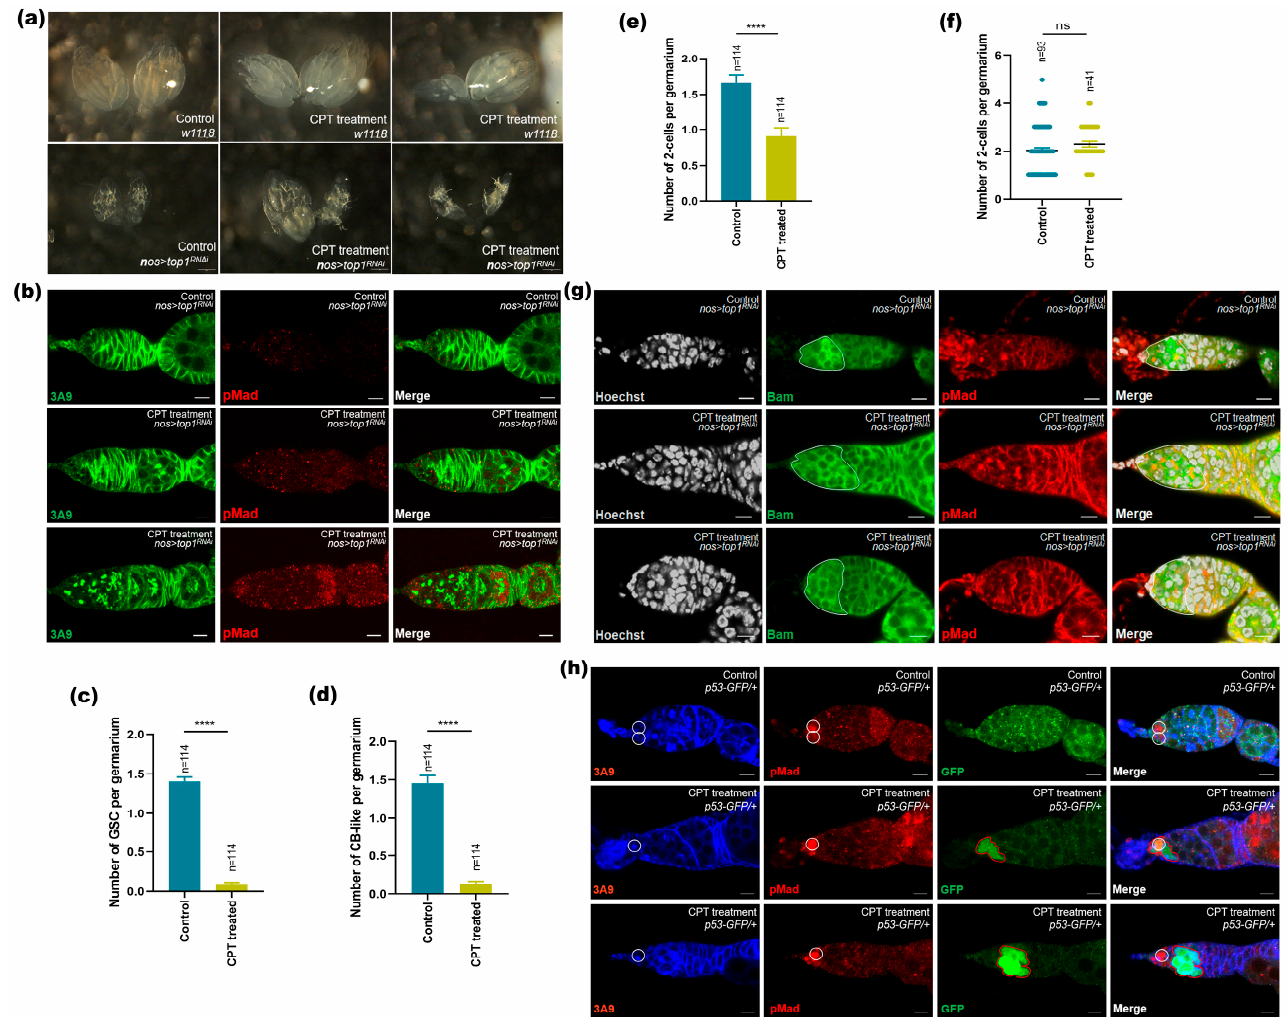
Figure 5. Top1 was involved in CPT-induced toxicity in germ cells. ( a ) Ovarian morphology from control and top1 RNAi germarium with or without CPT treatment. ( b ) Control and top1 RNAi germarium with or without CPT treatment and stained with anti-pMad (red) and anti-3A9 (green). ( c ) GSC quantification results are shown. ( d ) CB-like quantification results are shown. ( e ) Two-cell cysts quantification results are shown. ( f ) Two-cell cysts quantification results are shown by excluding the cases with germ cell loss. n is the number of the examined germaria; all the error bars represent SEMs; p values were calculated by comparing between top1 RNAi germarium with or without CPT treatment using Student’s t test. Blue indicated control, yellow indicated CPT treatment in ( c – f ). ( g ) Bam expression pattern in top1 RNAi germarium with or without CPT treatment staining with anti-3A9 (red) and anti-Bam (green). ( h ) Germaria of female flies expressed GFP under the control of transcriptional of p53 stained with anti-3A9 (blue), anti-GFP (green), and anti-pMad (red). White dash circle indicated GFP signals. The level of significance for the results was set at **** p < 0.0001. Scale bar, 10 μ m.